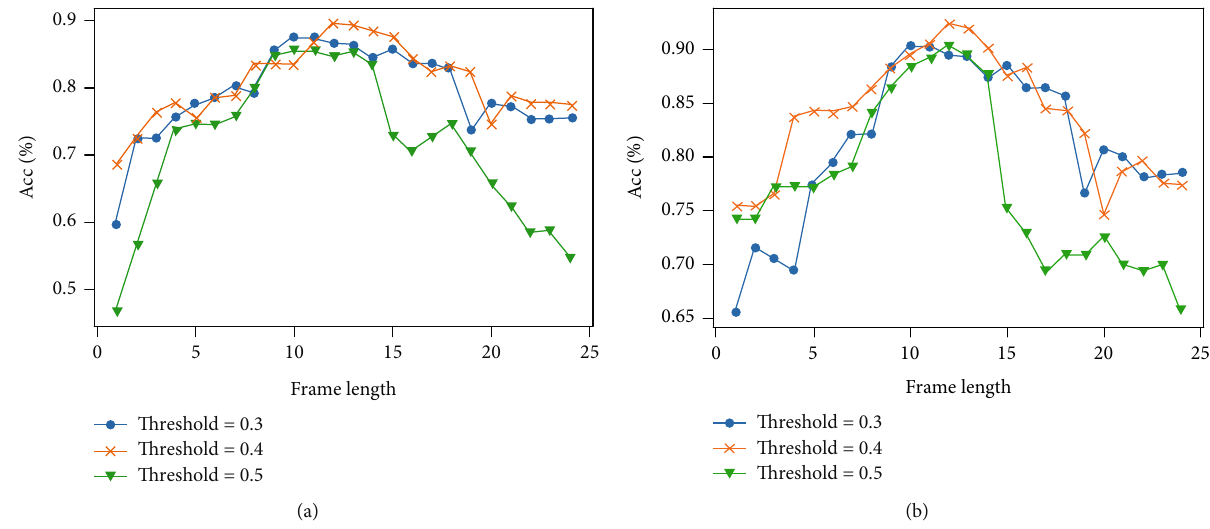
Figure 9: E ff ects of di ff erent threshold and Frame